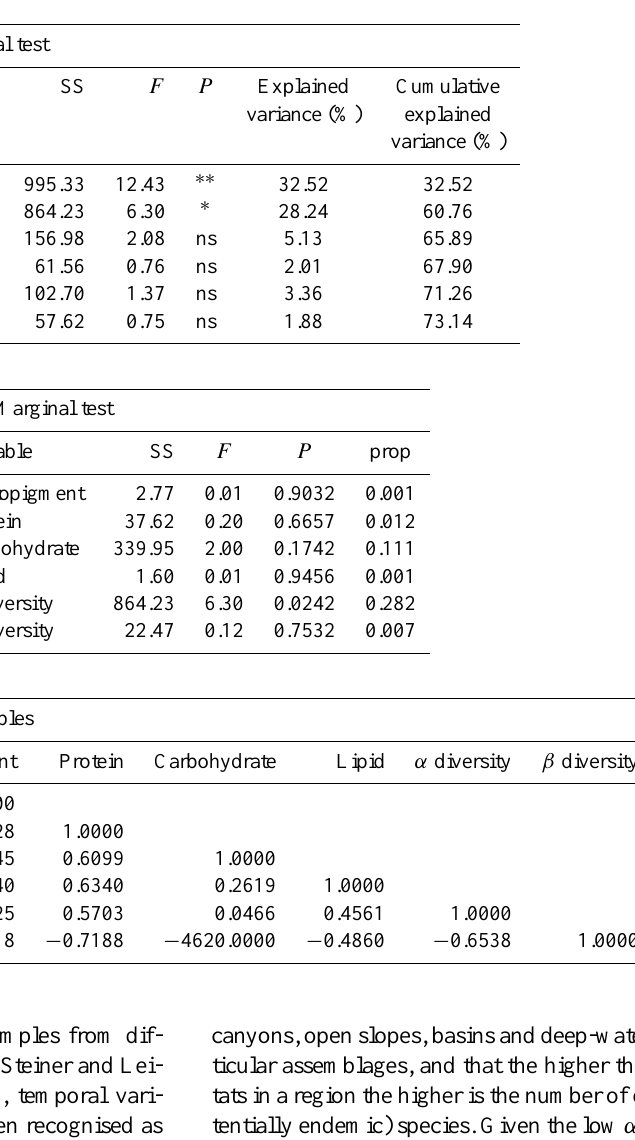
Table 6. Multivariate multiple regression analysis carried out on the γ diversity. ∗∗ P < 0 . 01; ∗ P < 0 . 05; ns: not